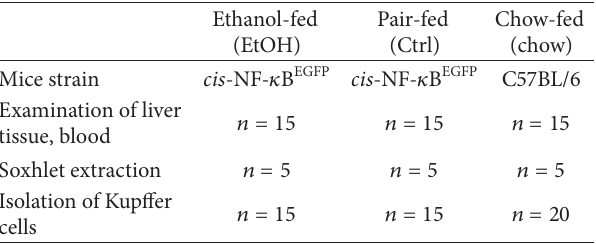
Table 1: Experimental